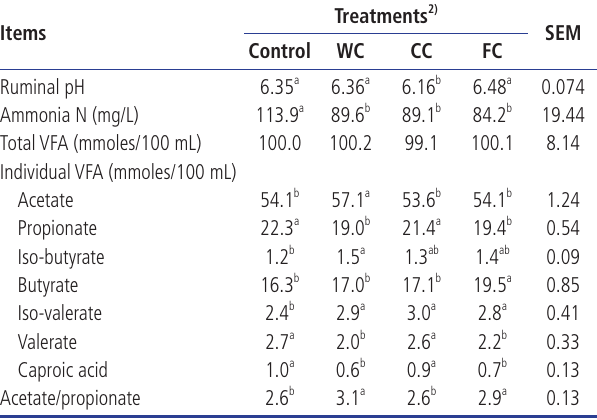
Table 3. Effect of feeding Korean domestic corn grain by different particle size on ruminal fermentation of Holstein steers fed total mixed ration as a basal 1)